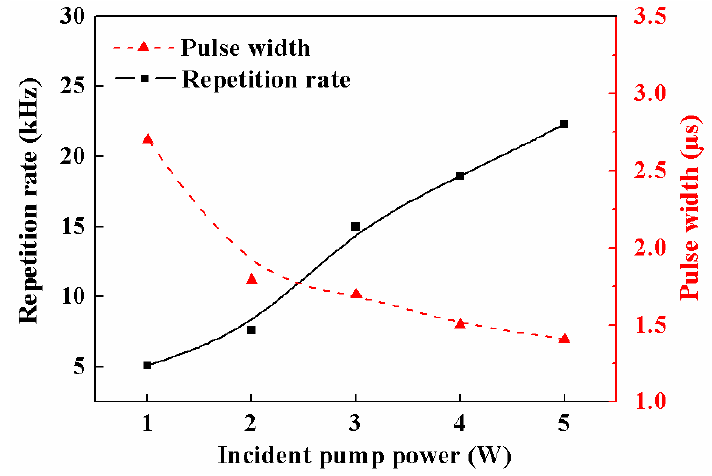
Figure 3. The repetition frequency and output pulse width (FWHM) of the Q-switched envelopes.